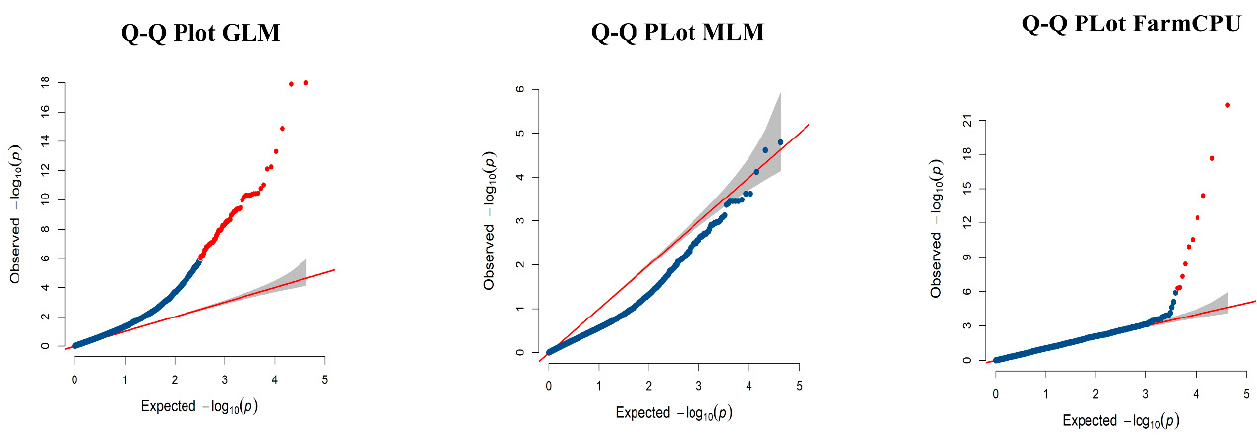
Figure 3. Quantile–quantile (Q–Q) plot of the general linear model (GLM), mixed linear model (MLM) and fixed and random model circulating probability unification (FarmCPU) model using prickle data. A Q–Q plot represents the extent to which the observed p -value distribution of the test statistic follows the null hypothesis i.e., expected p -value distribution (indicated by the red line). All points are on or near the middle red line if the observed values correspond to the expected values. Points deviating from the expected values under null hypothesis in the tail area indicate significant association. The Q–Q plots of the GLM and MLM models did not show sharp deviation from the expected p -value distribution in the tail area while the Q–Q plot of FarmCPU model showed a sharp deviation indicating adequate control of false positives and negatives. The Q–Q plot indicated that the population structure and kinship were well controlled for GWAS in the FarmCPU model. Shaded gray area represents 95% confidence